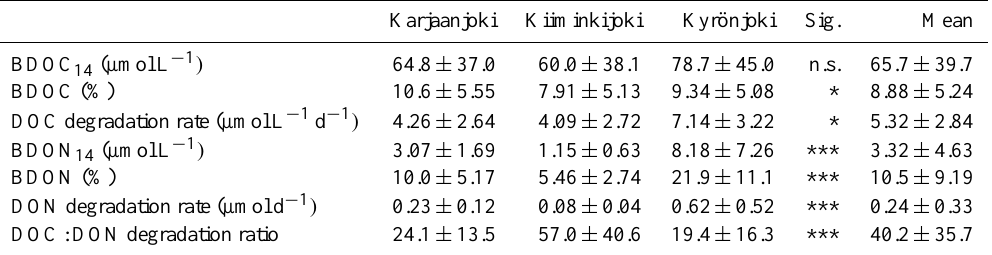
Table 3. Average amounts and standard deviations of biologically degradable DOC (BDOC) and DON (BDON), their proportion of the total DOC on DON pool, the degradation rates during the experiments and the DOC:DON ratios of degraded DOM. Since experiment durations varied (from 12 to 18d), BDOC and BDON amounts are normalized to 14d (BDOC 14 and BDON 14 , respectively). Average values of each estuary include every season and every water type. The Karjaanjoki catchment has mixed land use with most urban areas of the three catchments, the Kiiminkijoki catchment is dominated (80% of total area) by mostly natural forests and peatlands, and the Kyrönjoki catchment is most heavily influenced by agriculture (25% of total area). Significance level of differences between estuaries (Sig.) as analyzed by ANOVA is also given: * < 0.05, *** < 0.001, n.s.: not